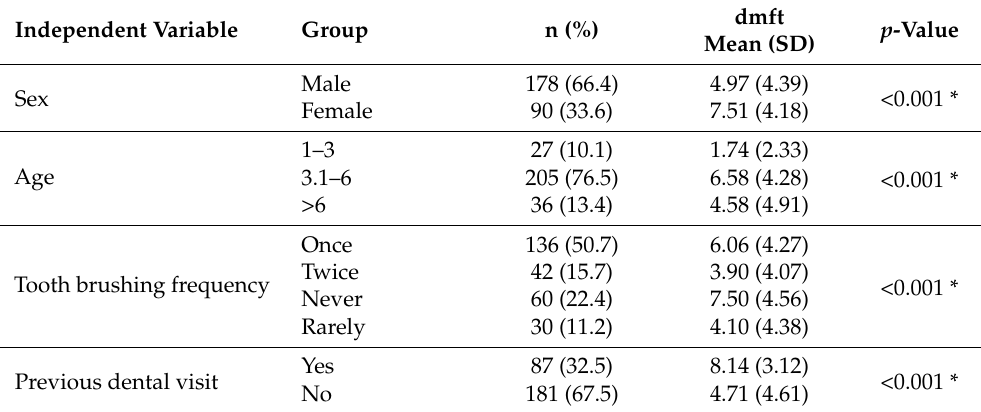
Table 1. Comparison of dmft scores based on gender, age, tooth brushing, and previous dental visit. Independent Variable